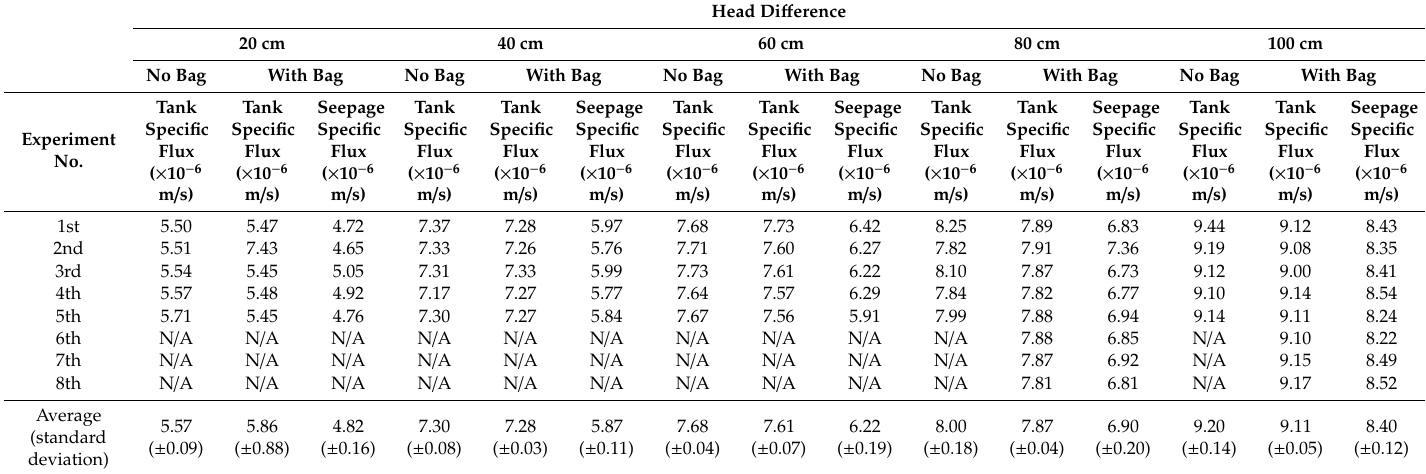
Table 3. Influx measurement experiment using the Type 2 collection